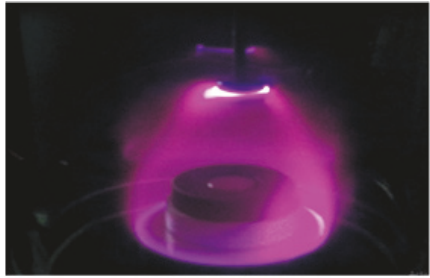
Figure 2: Plasma treatment of wood